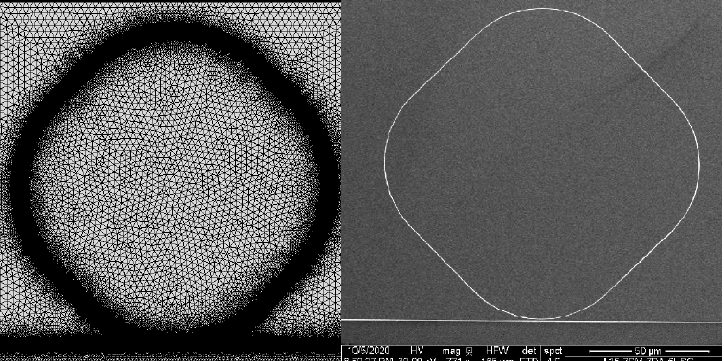
Figure 12. RCSS ( R c = 50 µ m) with 45 ◦ rotation in relation to the feed waveguide around the coupling point. ( left ) Hybrid meshing of the RCSS for FEA analysis; ( right ) SEM image of the fabricated RCSS for optical experiments.